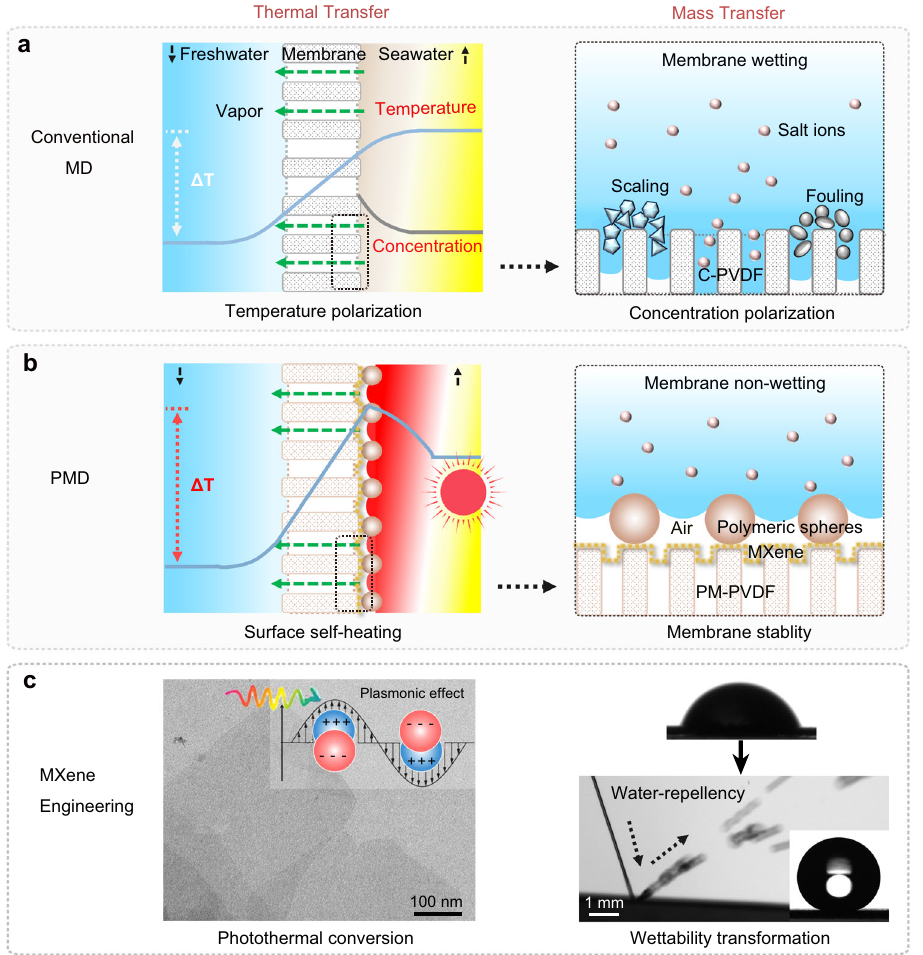
Fig. 1 Design concept of the PM-PVDF membrane for PMD. a The conventional MD process with thermal inef fi ciency and membrane wetting issues using C-PVDF membrane due to the inherent temperature and concentration polarization effect. MD process involves hot seawater (yellow) and cold freshwater (blue) fl ow on the opposite sides of a porous hydrophobic membrane, which allows for vapor permeation established by cross-membrane temperature gradient Δ T , while rejects the liquid water and salt ions. The blue line represents the temperature polarization with a progressive decline of Δ T owing to inherent heat loss at the feedwater side as a result of continuous water-to-vapor transition. The yellow color shading represents temperature decline near the feed/membrane interface compared with the initial feed temperature (yellow). The gray line represents concentration polarization with a gradual increase of salts concentration close to the interface, which intensi fi es the propensity of wetting transition-induced membrane fouling and scaling. b Optimized PMD process with localized surface self-heating and superhydrophobic-dependent membrane stability endowed by PM-PVDF membrane. The PM-PVDF membrane enables the enhanced Δ T by photothermal effect and non-wetting performance by the superhydrophobic hierarchical MXene layer with polymeric nanospheres. The typical red color shading represents the temperature increase near the feed/membrane interface compared with the initial feed temperature (yellow), resulting from the localized surface heating through the photothermal effect. c MXene engineering that achieves photothermal conversion and wettability transformation from hydrophilicity to superhydrophobicity. Left: TEM image of MXene nanosheets and inset image shows the schematic plasmonic effect-enhanced photothermal conversion of MXene. Right: contact angles at the initial state and after engineering with strong water